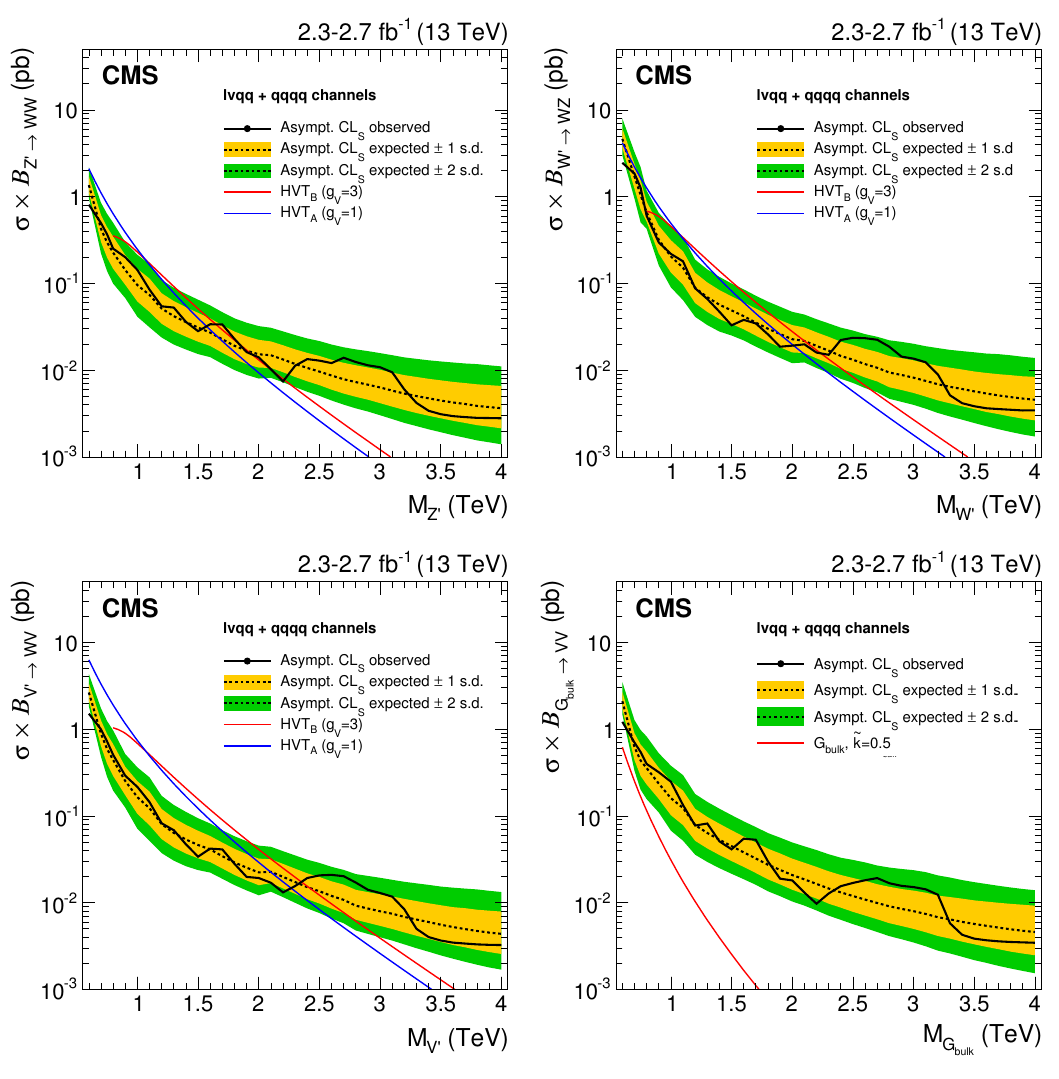
Figure 6 . Observed (black solid) and expected (black dashed) 95% CL upper limits on the produc- tion of a narrow-width resonance decaying to a pair of vector bosons for di(cid:11)erent signal hypotheses. In the upper plots, limits are set in the context of a spin-1 neutral Z 0 (left) and charged W 0 (right) resonances, and compared with the prediction of the HVT Models A and B. In the lower left plot, limits are set in the same model under the triplet hypothesis (W 0 and Z 0 ). In the lower right plot, limits are set in the context of a bulk graviton with k=M Pl = 0 : 5 and compared with the predic- tion. For G bulk , Z 0 and triplet signals (W’ signal) with masses < 0.8 TeV ( < 0.75 TeV), the limits are obtained from the low-mass ‘(cid:23) +jet channel, while for the higher masses they are obtained from the high-mass ‘(cid:23) +jet and dijet